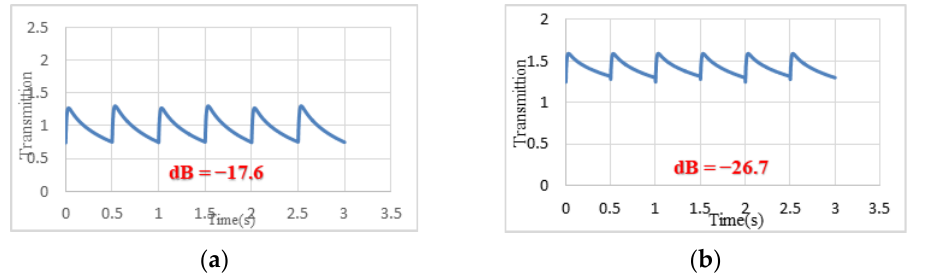
Figure 3. Determination of transmission and flicker. ( a ) Transmission and flicker of C; ( b ) Transmis- sion and flicker of D.